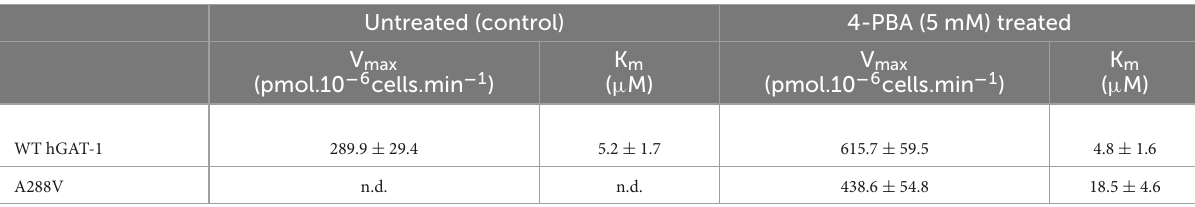
K m andV max valuesweredeterminedfromdatashownin Figure5B .Thevaluesaremeans ± S.E.M.fromthreeindependentexperimentsperformedintriplicate.“n.d.”,notdeterminable, i.e., GABA uptake activity by A288V could not be accurately measured in the absence of 4-phenylbutyrate (4-PBA) treatment. The K m values of WT and mutant transporters differed significantlywithorwithoutpharmacochaperonetreatment( p <